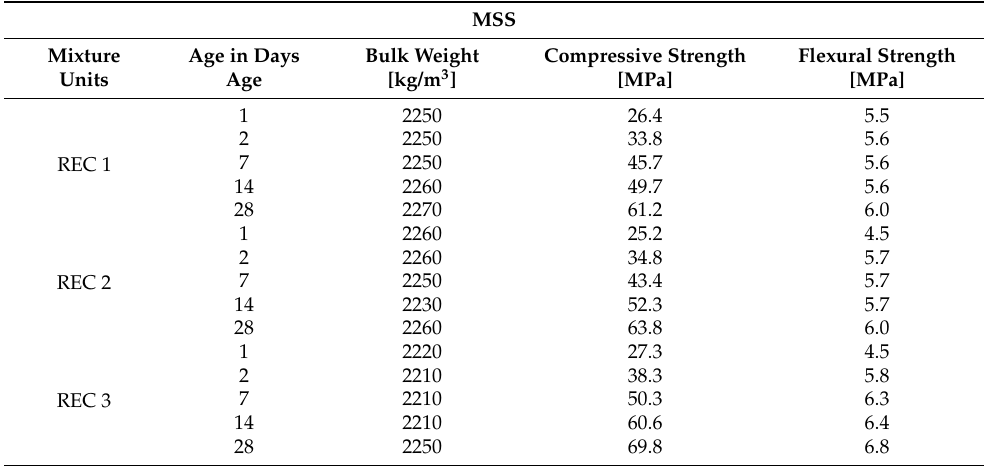
Table 9. Results of basic physical and mechanical properties of the prepared mixtures.